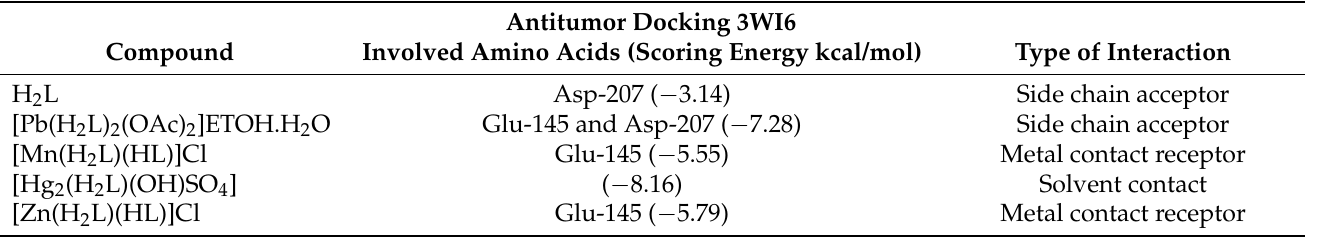
Table 10. Comparison of binding affinity of the complexes against the active pocket of mitogen-activated kinase (MK-2) (PDB ID: 3WI6).